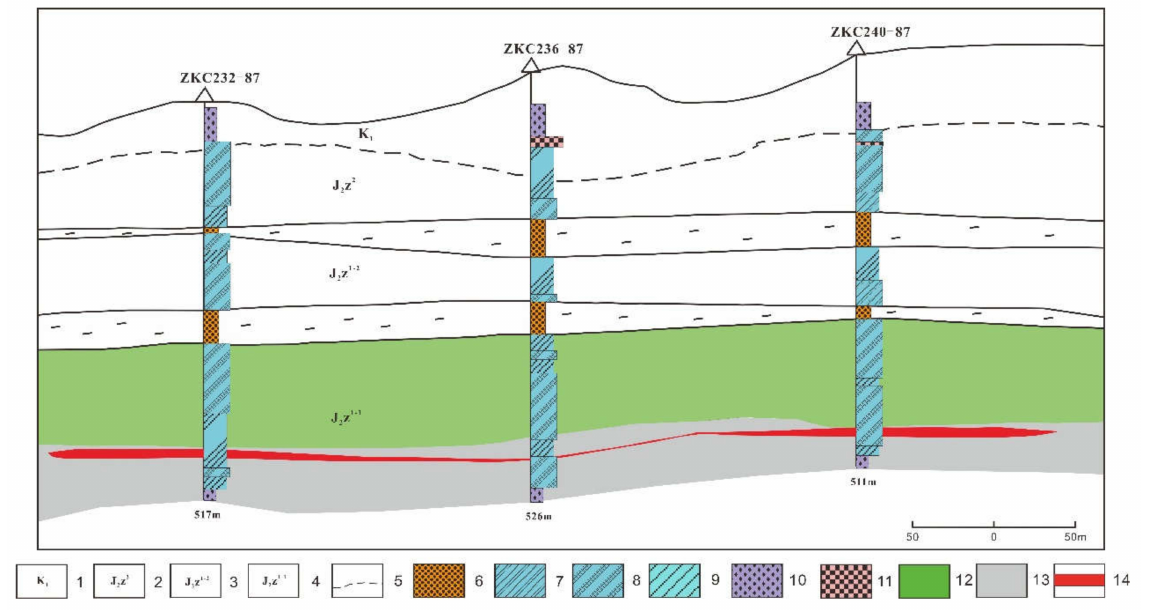
Figure 4. The profile of borehole ZKC232-87, ZKC236-87, and ZKC240-87 of Tarangaole deposit. 1. Lower Cretaceous; 2. Upper Member of Zhiluo Formation; 3. Upper sub-member of Zhiluo Formation; 4. Lower sub-member of Zhiluo Formation; 5. Lithologic boundary; 6. Mudstone; 7. Fine- grained sandstone; 8. Medium-grained sandstone; 9. Coarse-grained sandstone; 10. Conglomerate; 11. Calcareous sandstone; 12. Green sandstone; 13. Gray sandstone; 14. Orebody. The bottom of the Lower Member of Zhiluo Formation is coarse-grained, mainly composed of gray conglomerate, pebbly sandstone, and coarse-grained sandstone. The structure is loose and gradually changes to the gray-green medium-grained sandstone and fine-grained sandstone upwards, with thin layers of gray-green calcareous sandstone interspersed locally. A large number of organic matter is observed in mudstone and in sandstone (Figure 5), without calcareous nodules.